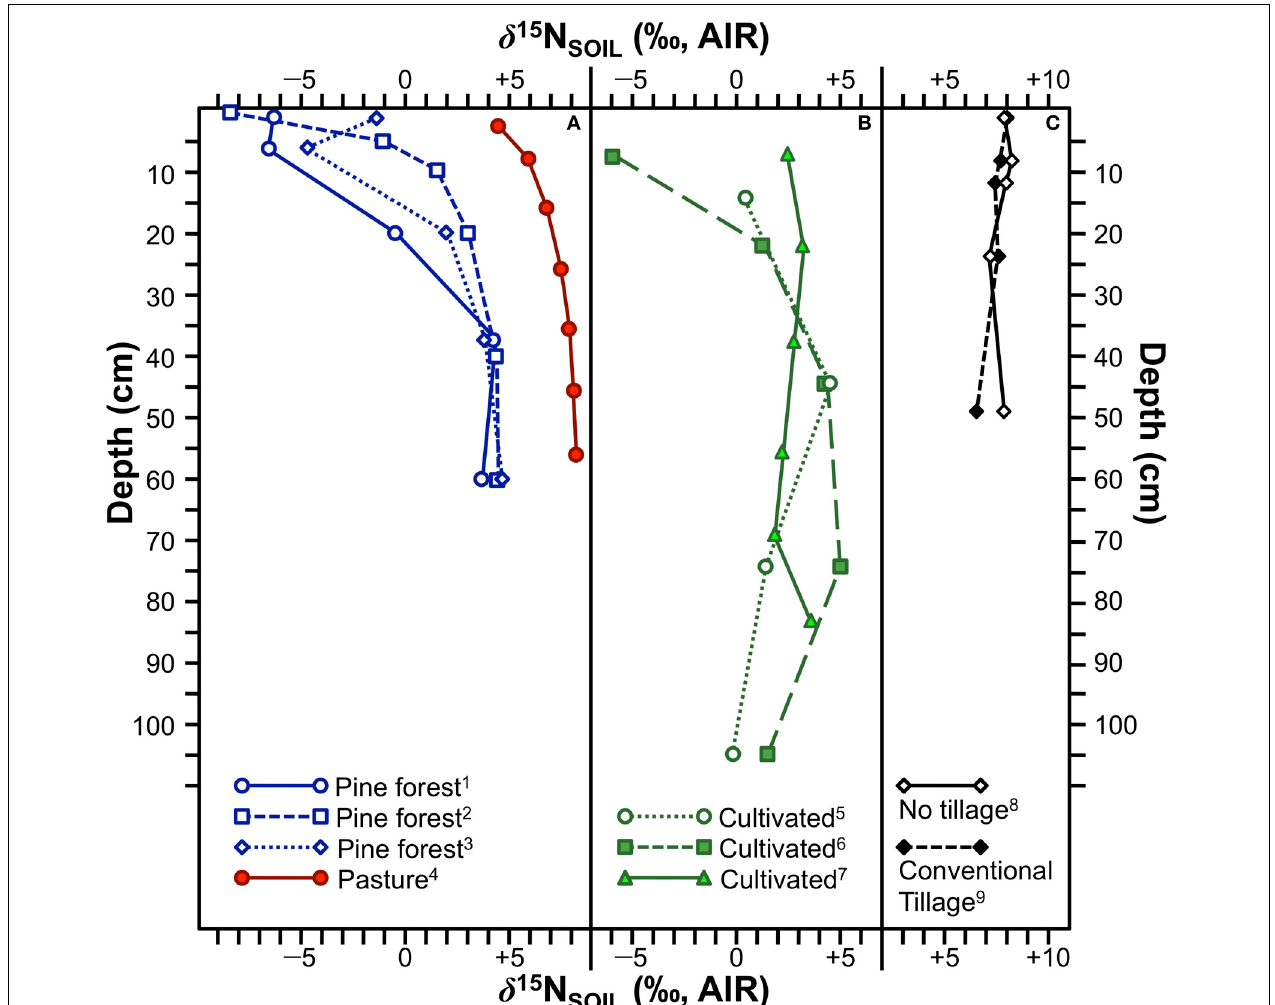
FIGURE 7 | δ 15 N variation with depth in soil profiles under various conditions. (A) Soil profiles for three pine forests and one pasture. The much larger and abrupt shift in δ 15 N with depth is typical of N-limited forests. (1) pine forest, Netherlands (data from Koopmans et al., 1997), (2) pine forest, USA (redrawn from Hobbie and Ouimette, 2009), (3) pine forest, Netherlands (data from Koopmans et al., 1997), (4) native pasture, southeastern Australia